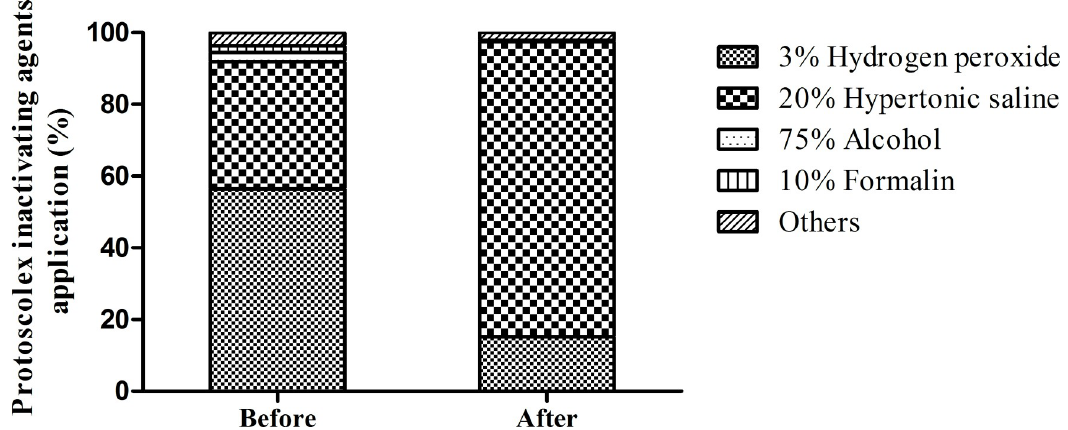
Fig 3. Use of scolecidal agents in open cyst operations before and after program implementation. Before program implementation, 3% hydrogen peroxide was used in 56.6% of cases and hypertonic saline in 35.4% of cases. After program implementation, hypertonic saline used increased to 82.3% and the application of 10% formalin decreased to 0%. The overall changes had significance of p < 0.001 by the chi-square test.